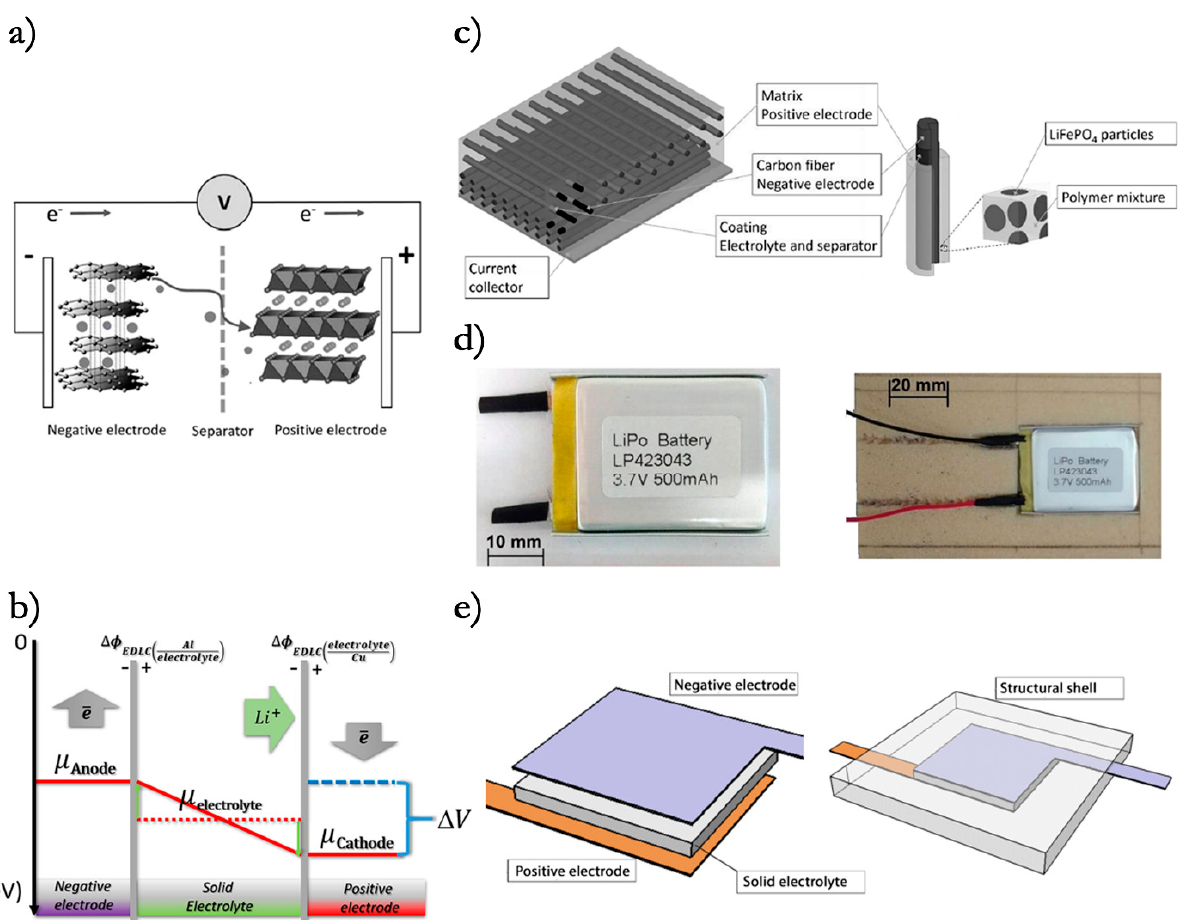
Figure 2. Structural power composite principles: ( a ) Lithium-ion battery [20] and ( b ) Solid state battery [21]. Structural power composite applications: ( c ) Multifunctional material with structural battery electrolyte [20], ( d ) Multifunctional systems with market available lithium-ion batteries embedding [10] and( e ) All-solid-state structural battery.